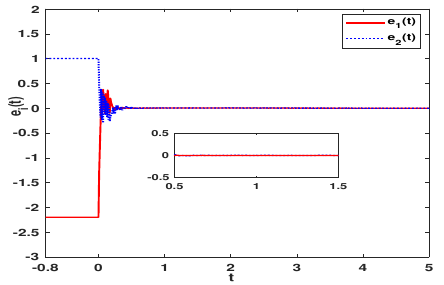
Figure 10. The synchronization errors e i ( t ) under the FTSMC.